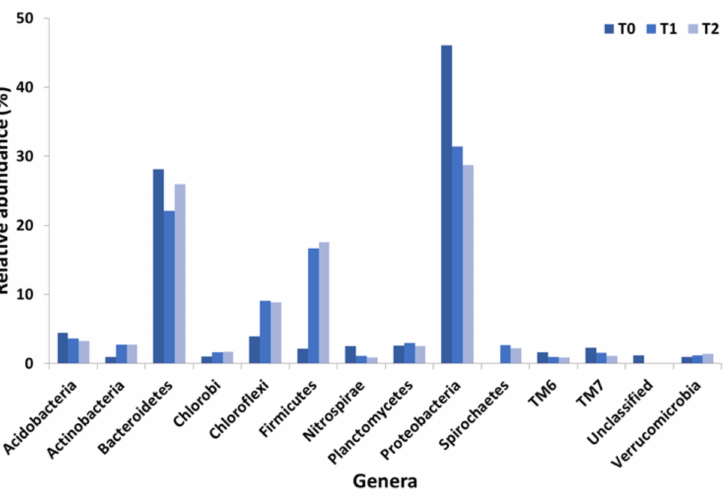
Figure 11. Relative abundance of the most abundant (i.e., having percentage values > 1) bacterial phyla identified by NGS analysis of the V3–V4 region of the 16S rRNA encoding gene in the activated sludge of T0, T1 and T2 conditions,